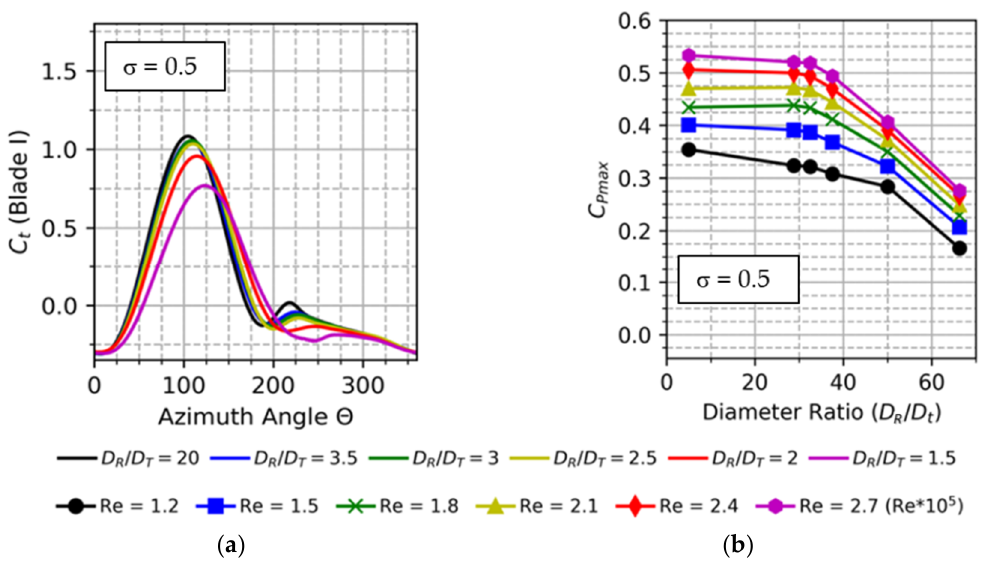
ff erent diametrical max for di